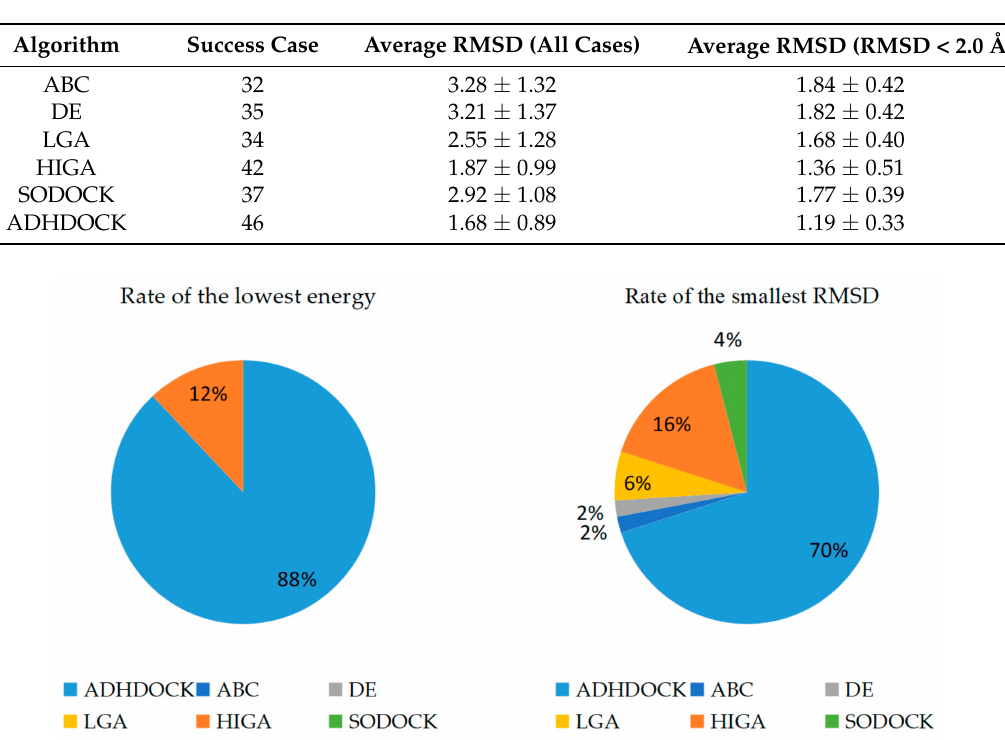
Figure 1. Rate of the lowest energy and the smallest root-mean-square deviation